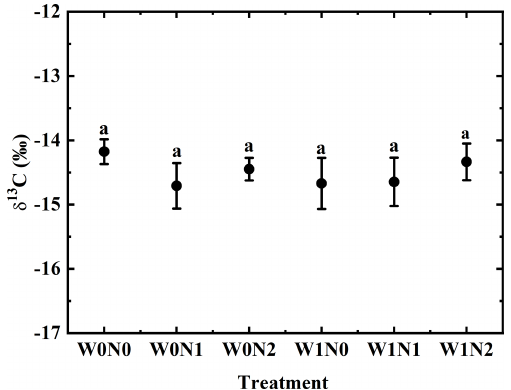
Figure 1. The δ 13 C of assimilating branches of Haloxylon ammod- endron under water (W) and nitrogen (N) additions. The spot repre- sents the mean value of four replicates with error bars denoting the standard error